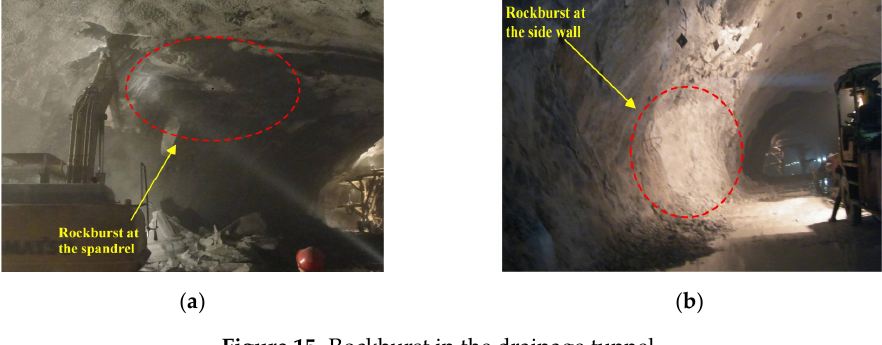
Figure 15. Rockburst in the drainage tunnel.